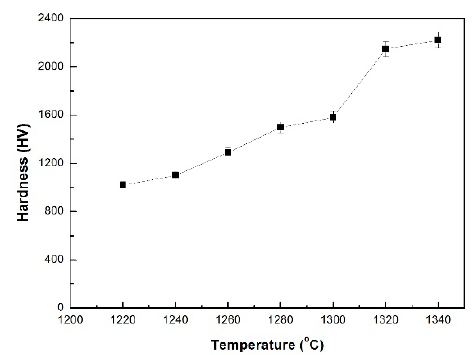
Figure 8. Hardness of oxidation surfaces treated at different temperatures for 3 h.